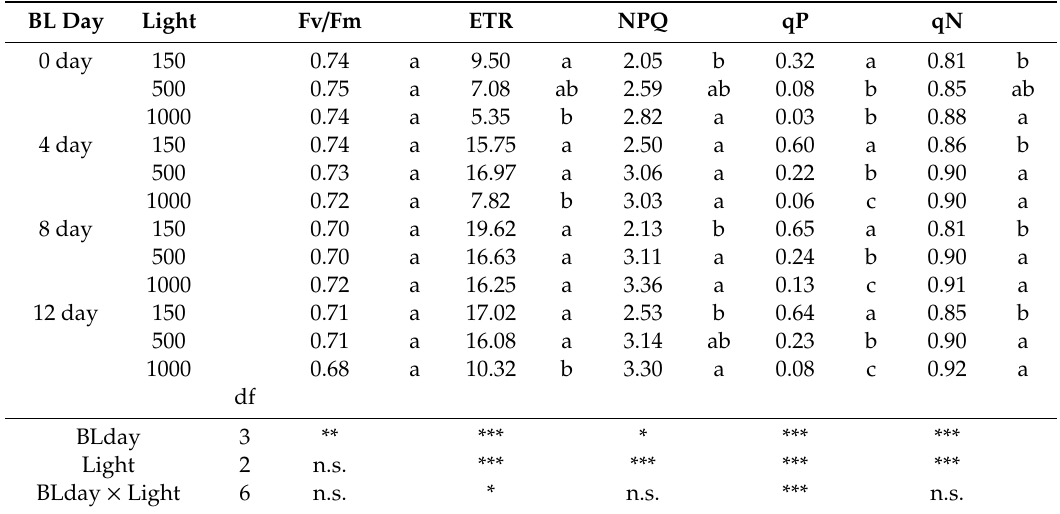
Table 2. E ff ect of various blue light (BL)-acclimation time courses on Chl F parameters of vanilla